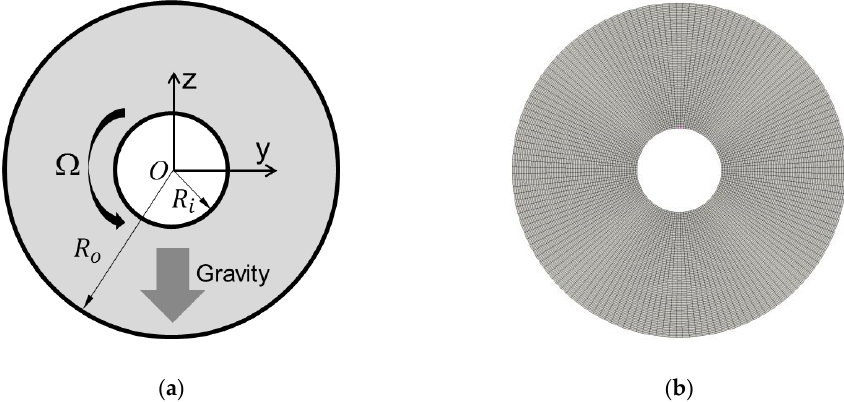
Figure 6. Geometry and computational grid of the two concentric cylinders. Figure 6. Geometry ( a ) and computational grid ( b ) of the two concentric